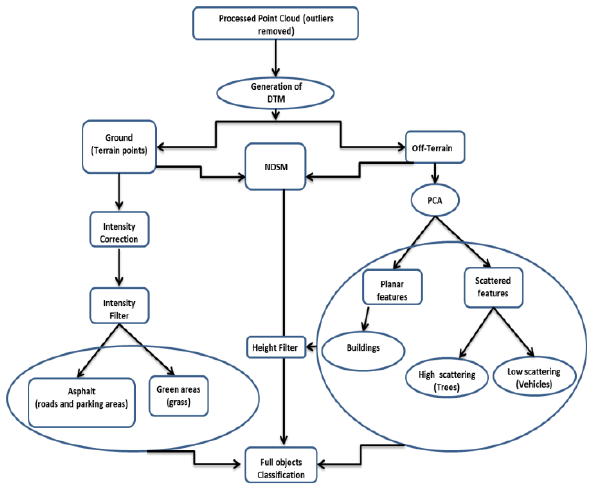
Figure 1. The general classification framework of airborne LIDAR